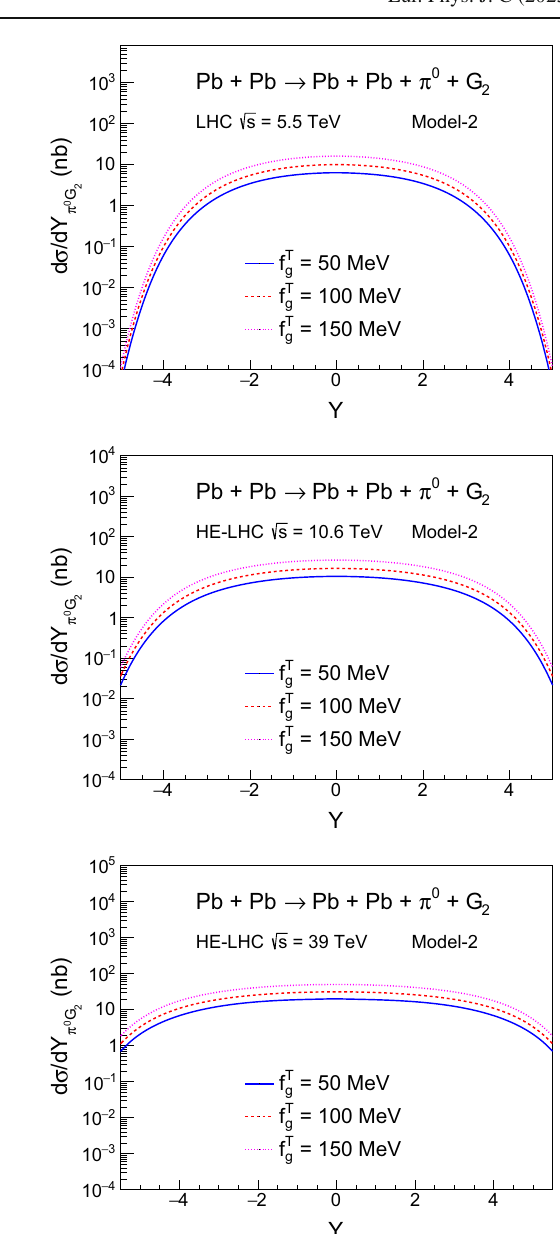
HE-LHC and FCC energies, respectively. The solid, dashed and dotted lines correspond to f T g = 50 MeV, 100 MeV and 150 MeV [31]